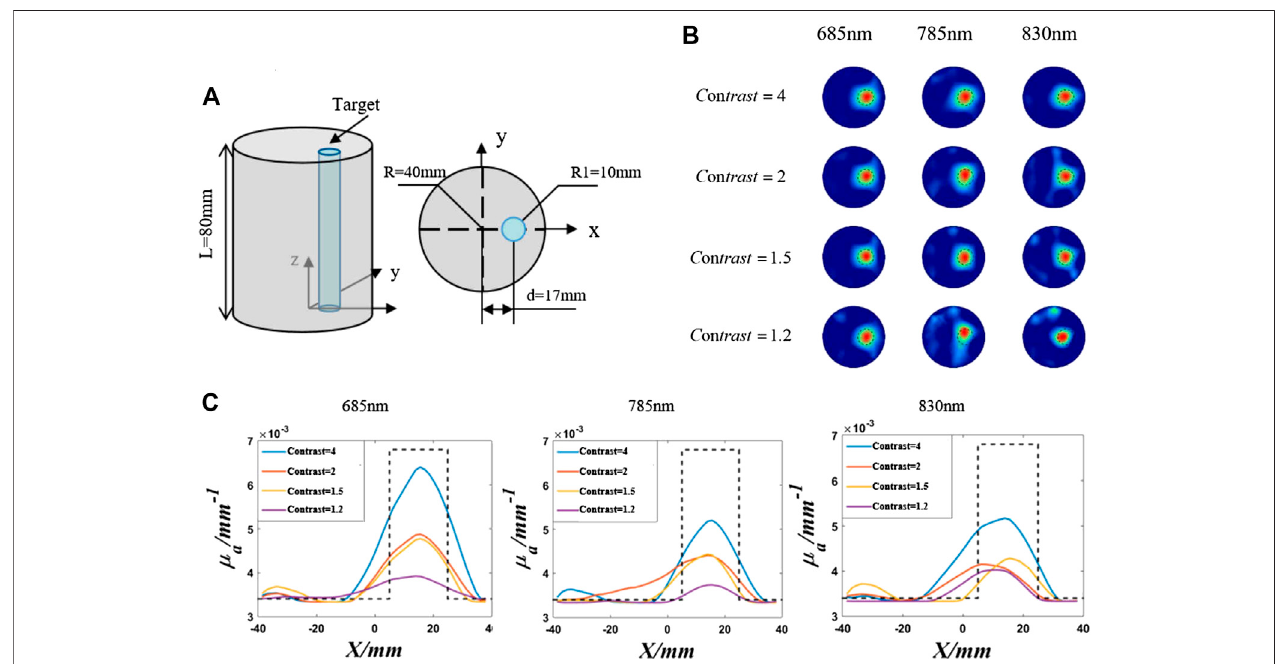
FIGURE7| Staticphantomexperiments: (A) sketchofthephantom, (B) cross-sectionalreconstructedimageswithfourdifferenttarget-to-backgroundabsorption contrasts at three wavelengths at Z (cid:2) 24 mm, and (C) pro fi les of the target-to-background absorption contrast along the X -axis.